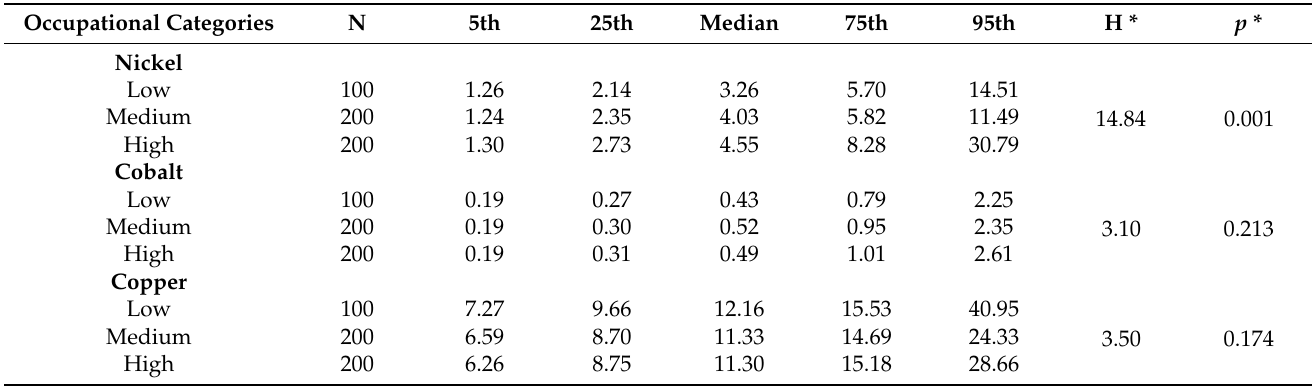
Table 2. The concentrations of major urinary metals among three occupational categories in the Jinchang cohort (ug/L